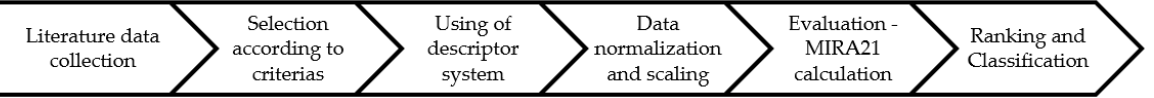
Table 2. Descriptor system of MIRA21 for TDA synthesis [24].